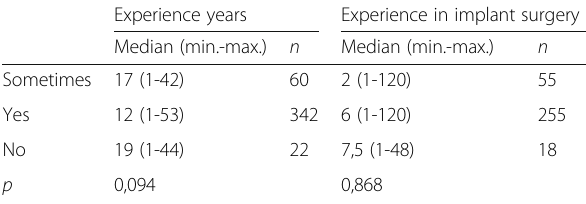
Table 5 The relationship between experience years and postoperative antibiotic prescription habit Experience years